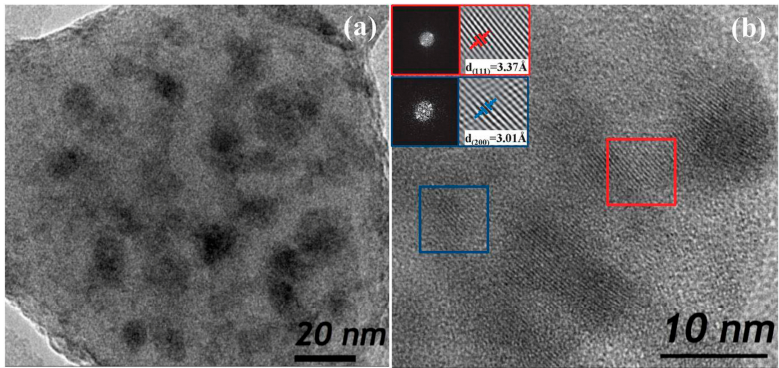
Figure 7. ( a ) TEM and ( b ) HRTEM images of 95SiO 2 -5BaGd (1 − x) Eu x F 5 . Inset show power spectrum (FFT pattern) and filtered higher-contrasted red and blue square nanoparticles [86].